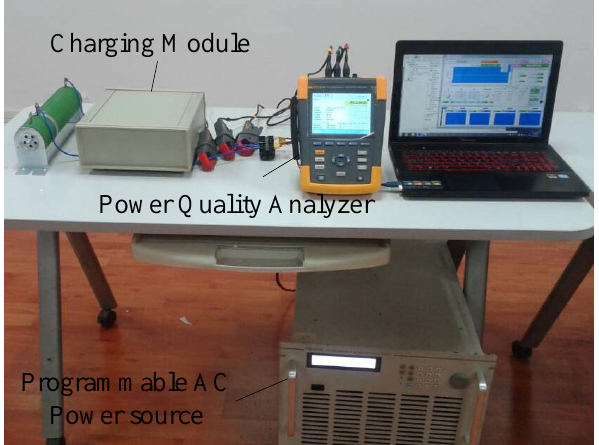
Figure 3. Experimental test platform for electric vehicle charger.